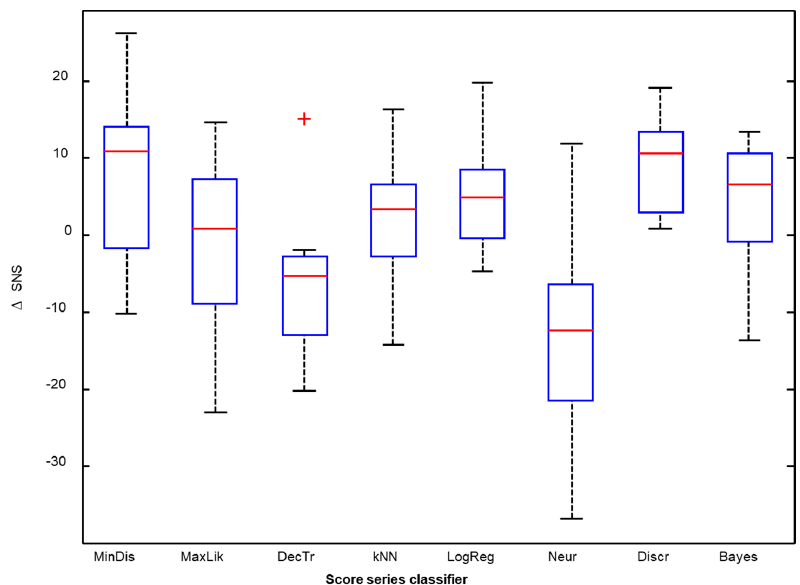
Figure 16. Improvement of the SNS obtained for each score-series classifier. Sensors 2018 , 18 , x FOR PEER REVIEW